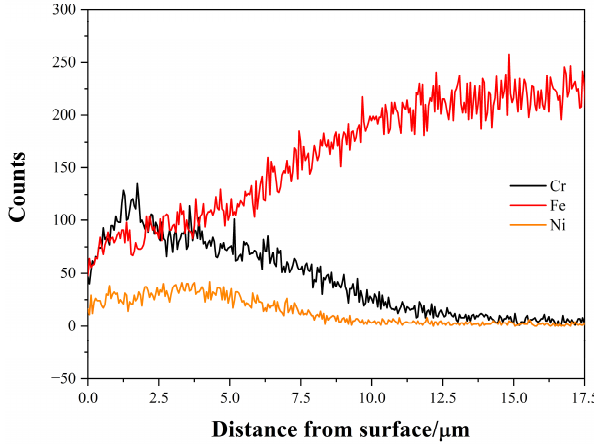
Figure 3. Counts distribution trend of the alloyed elements.